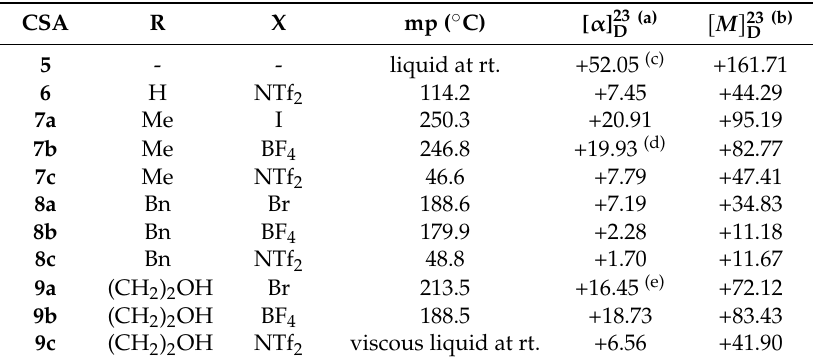
Table 1. Physical properties of compounds prepared from 2 .